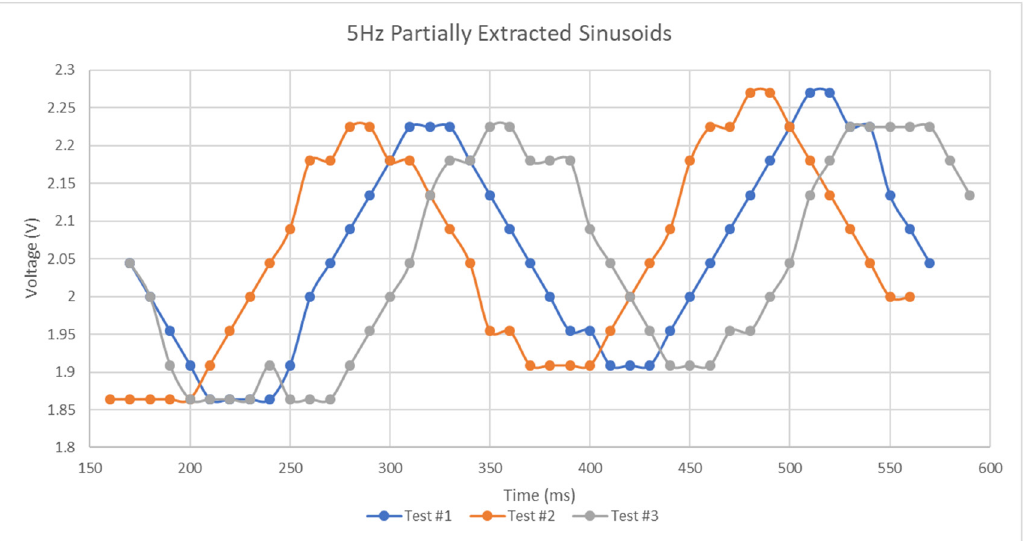
Figure 21. 5Hz sinusoid extractions. Figure 21. 5 Hz sinusoid extractions.